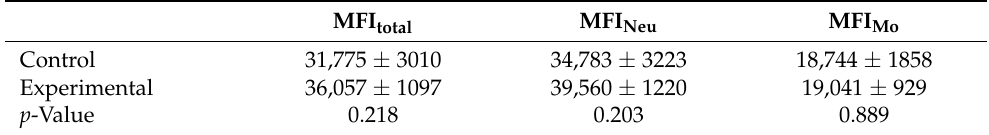
Table 5. Effect of humic substances on the engulfing capacity of the phagocytes expressed as mean fluorescence intensity (MFI).